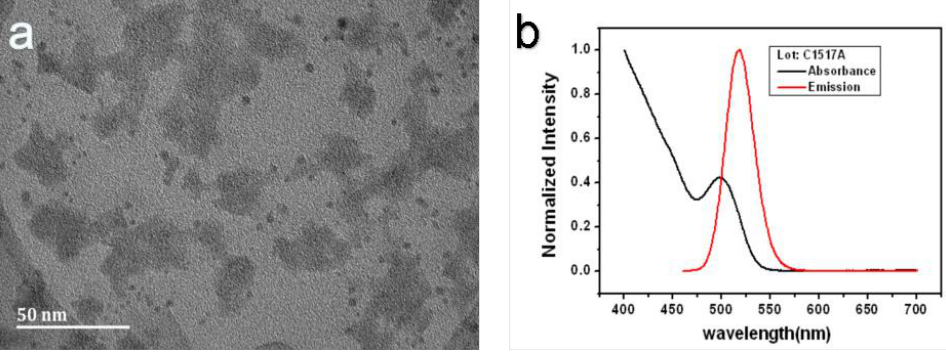
Figure 6. ( a ) The TEM image and ( b ) the absorption and emission spectra of QD